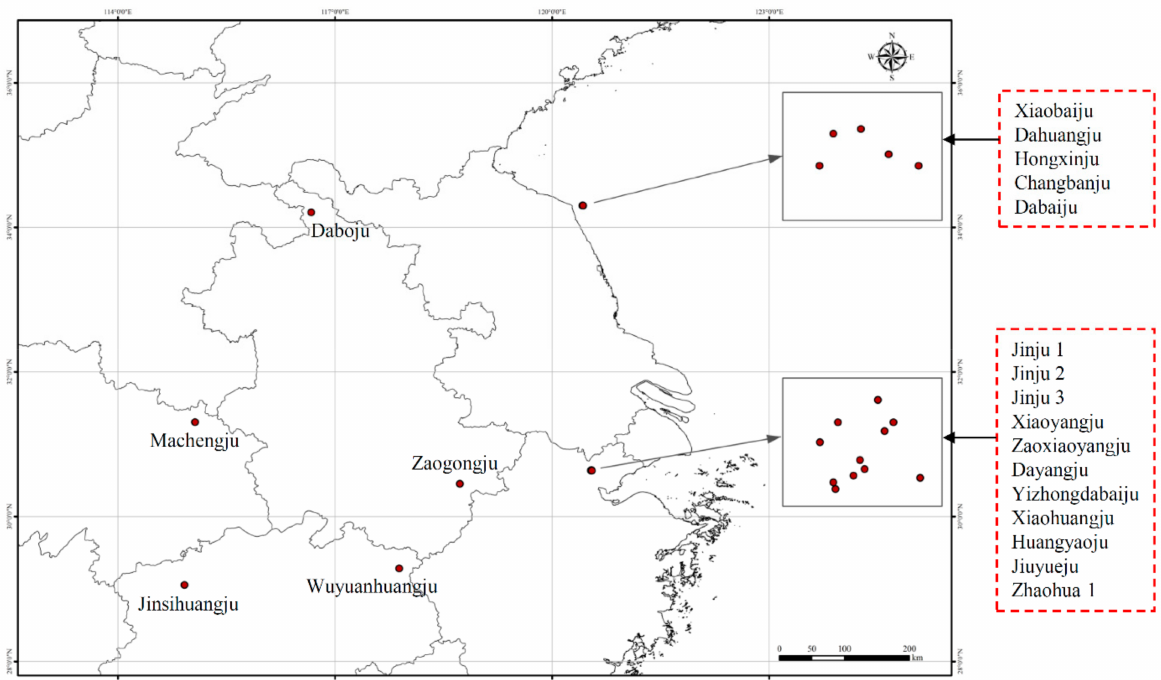
Figure 7. Sampling locations of 21 C. morifolium cultivars.